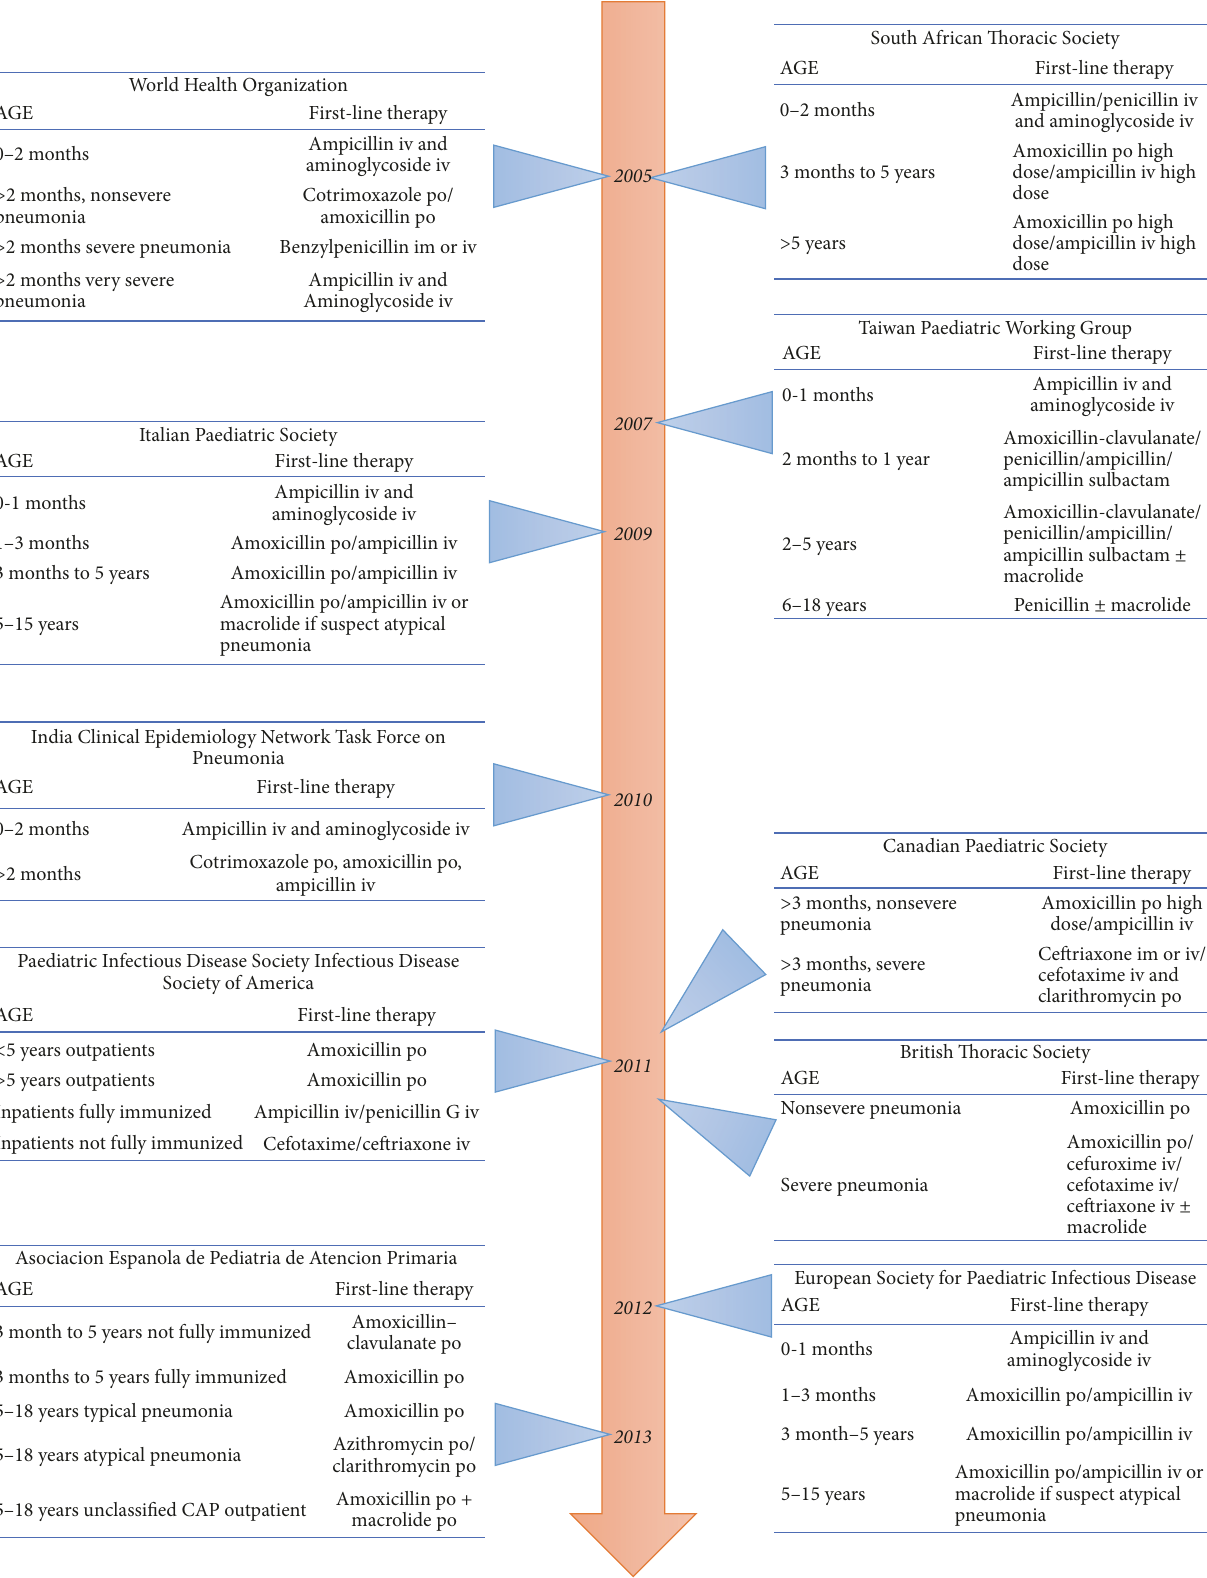
Figure 1: Pediatric CAP guidelines timeline [adapted by Berti et al., 2013